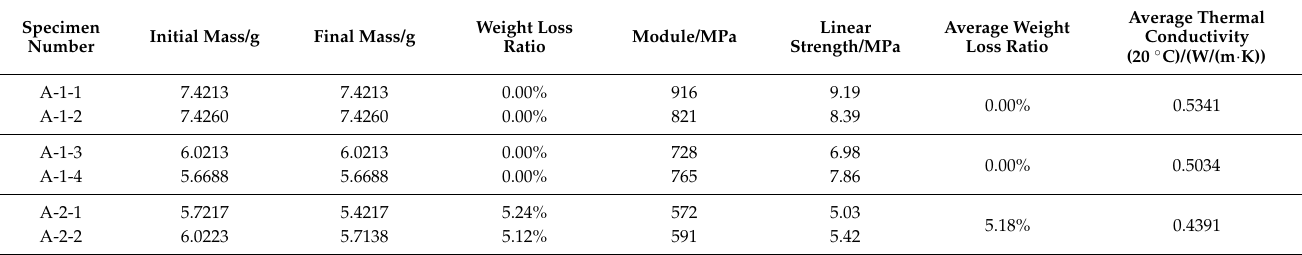
Table 1. Experimental